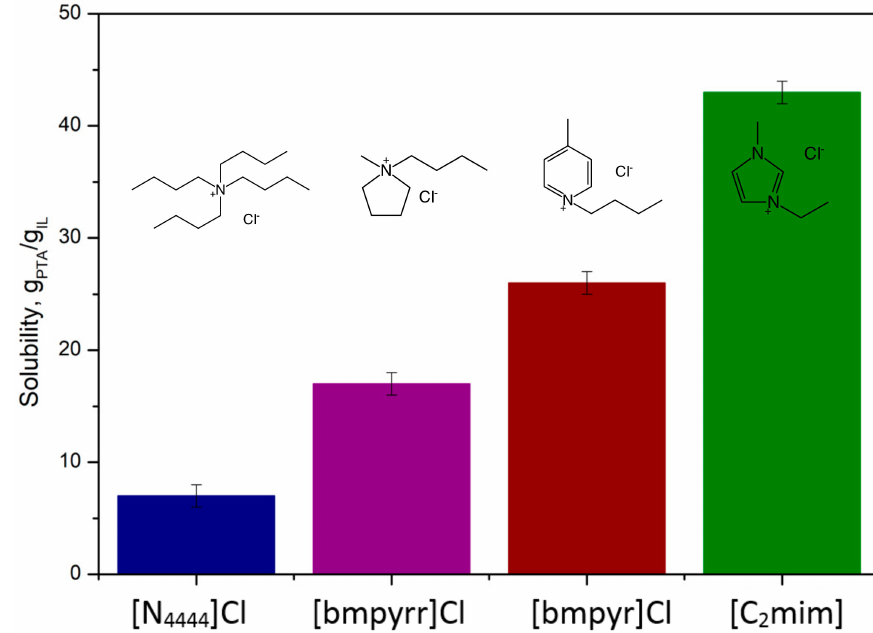
Figure 2. The influence of the structure of cation in ionic liquids on the solubility of PTA at 100 ◦